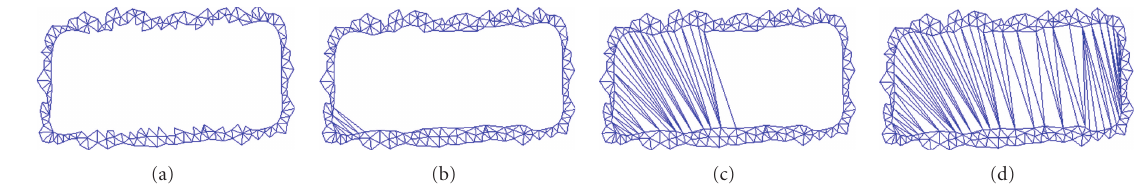
Figure 18: Triangulation mechanism. (a) Initial hole. (b) Eliminating saw tooth and smooth the boundary. (c) Closing the hole in the zipping way. (d) The triangulation results. Table 3: Models corresponding to di ff erent boundaries in Table 2 before and after shape restoration. Number of boundary